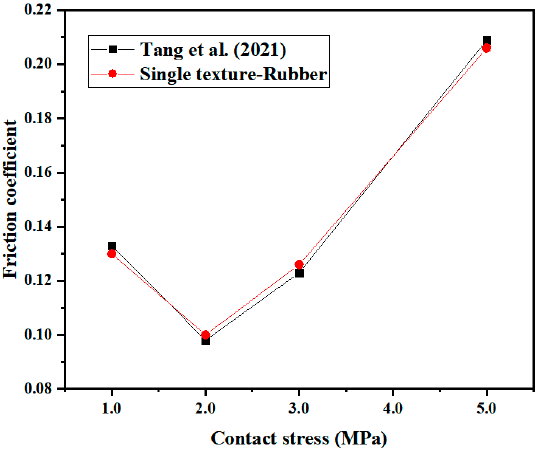
Figure 5. Comparison of the influence of the crescentiform texture on the friction coefficient under different contact pressures.